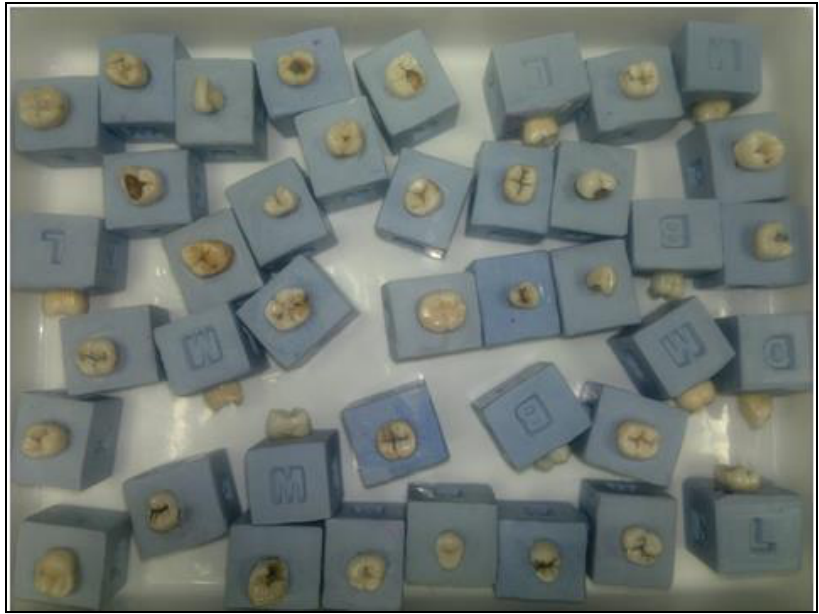
Figure 4. The IMU Reference Set of extracted